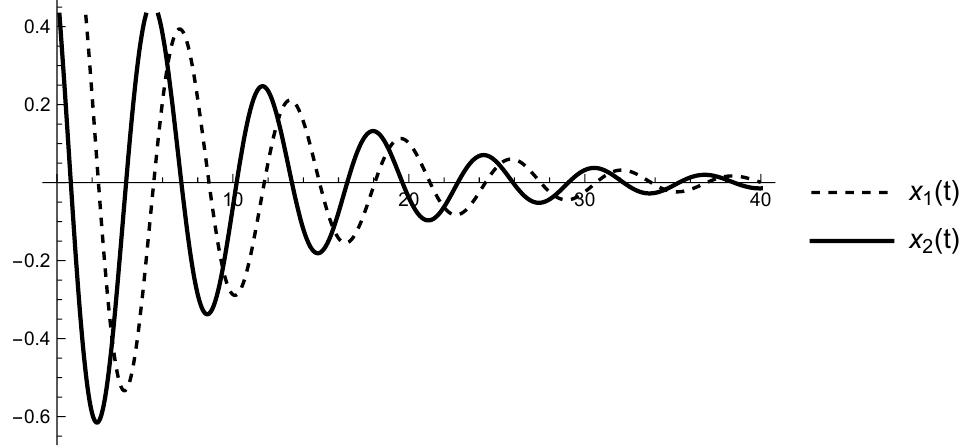
Figure 2. Graph of the solutions (37) for ρ = 0.9, g 2 ( t ) ≡ −